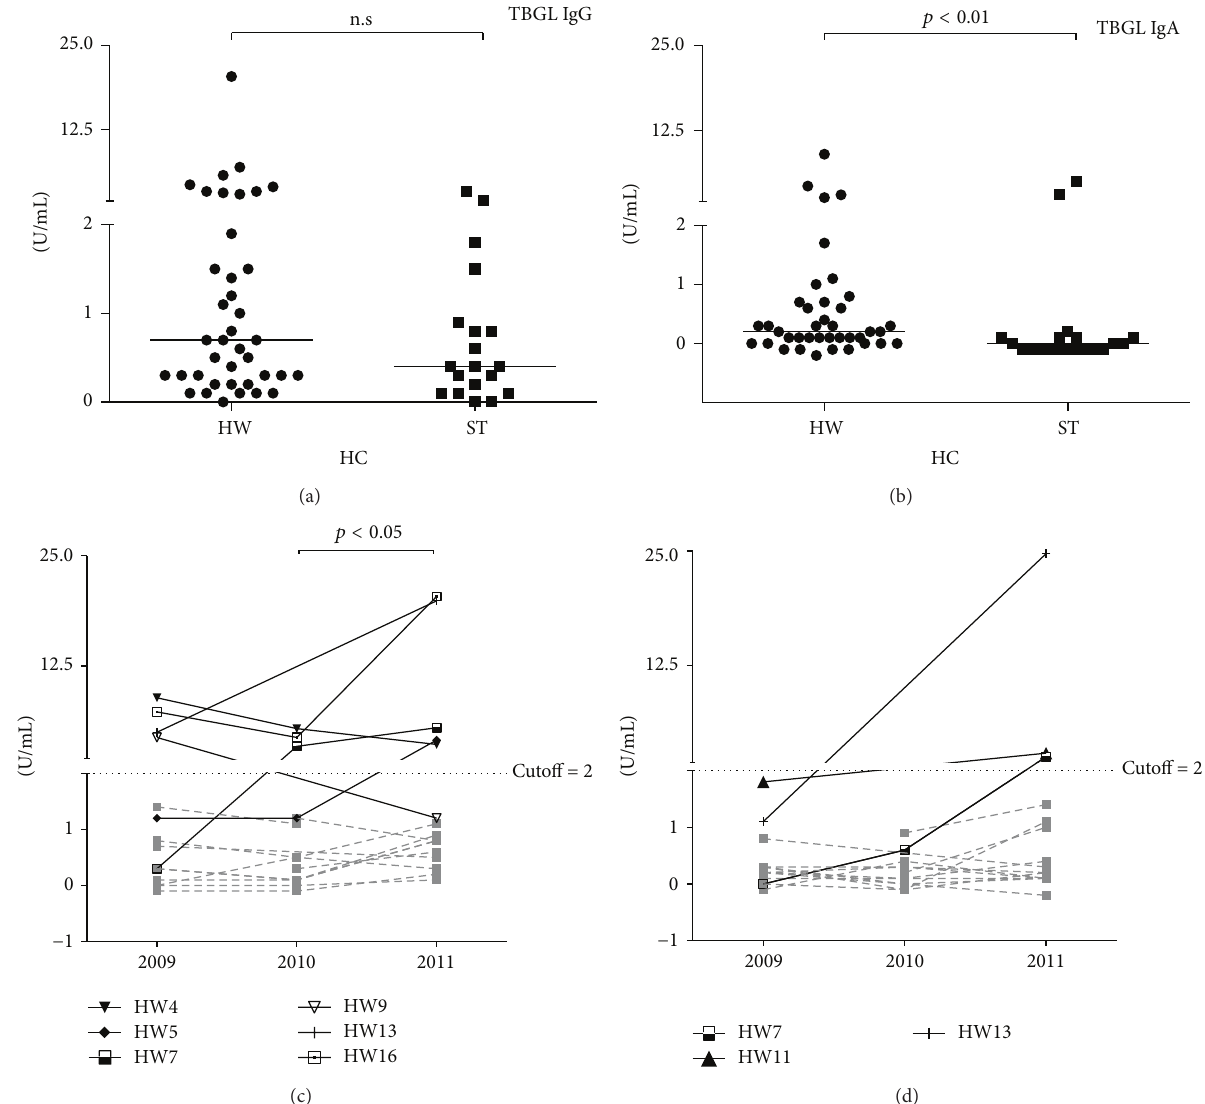
Figure 4: Detection of anti-TBGL antibodies and anti-LAM IgG among HC including HW and ST and follow-up study of HW. HW refers to health care workers; ST refers to new enrolled students (a and b); 2009, 2010, and 2011 refer to different years of sample collection (c and